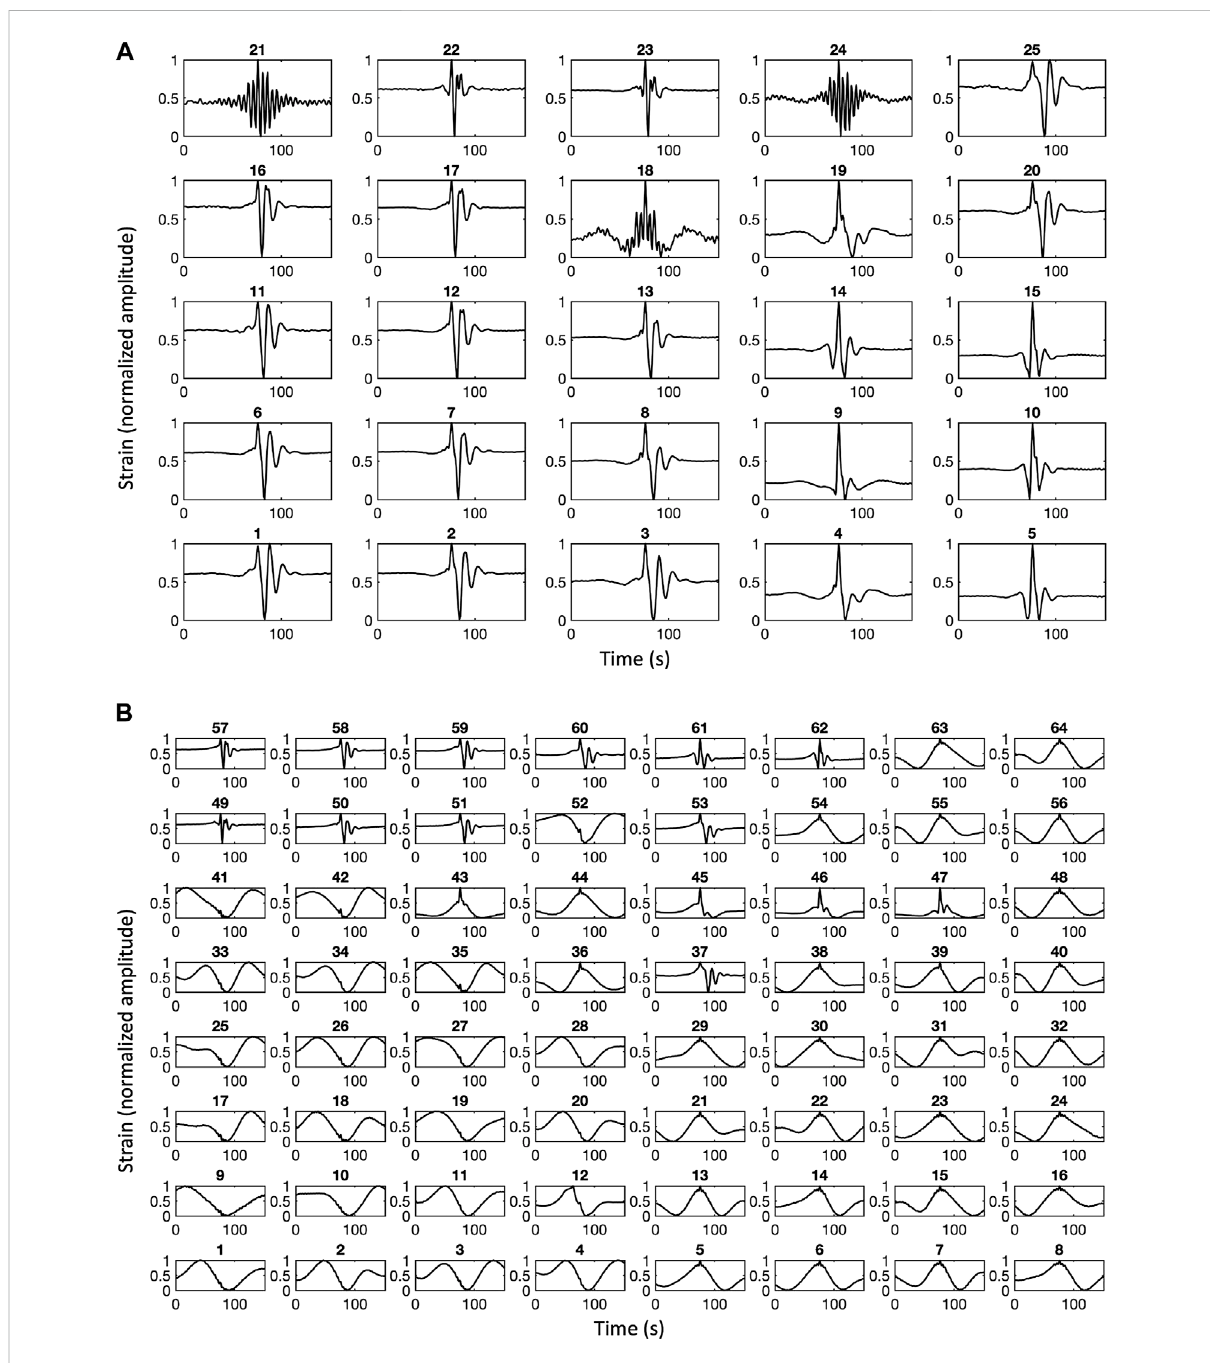
FIGURE 8 Normalizedstackedwaveformsbelongingtothe i thnodeoftheSOMmap (A) stackedwaveformoffamiliesfoundbytheVLPSOMalgorithm (B) stacked waveform of families found by the ULP SOM algorithm. The horizontal axis indicates the time in